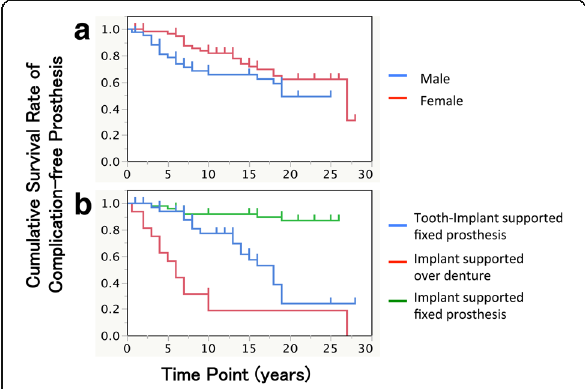
Fig. 6 Cumulative survival rate of complication-free prostheses by a gender ( p = 0.1220) and b type of prostheses ( p < 0.0001). Log rank test was used for assessing statistical